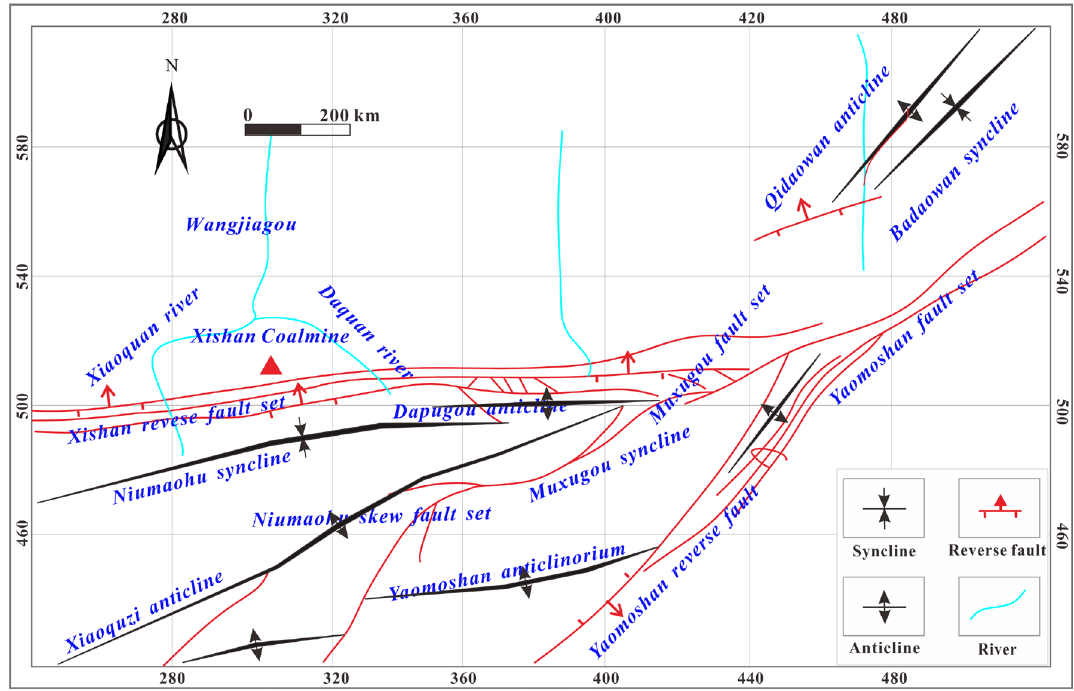
Figure 1. The structural position of the Xishan